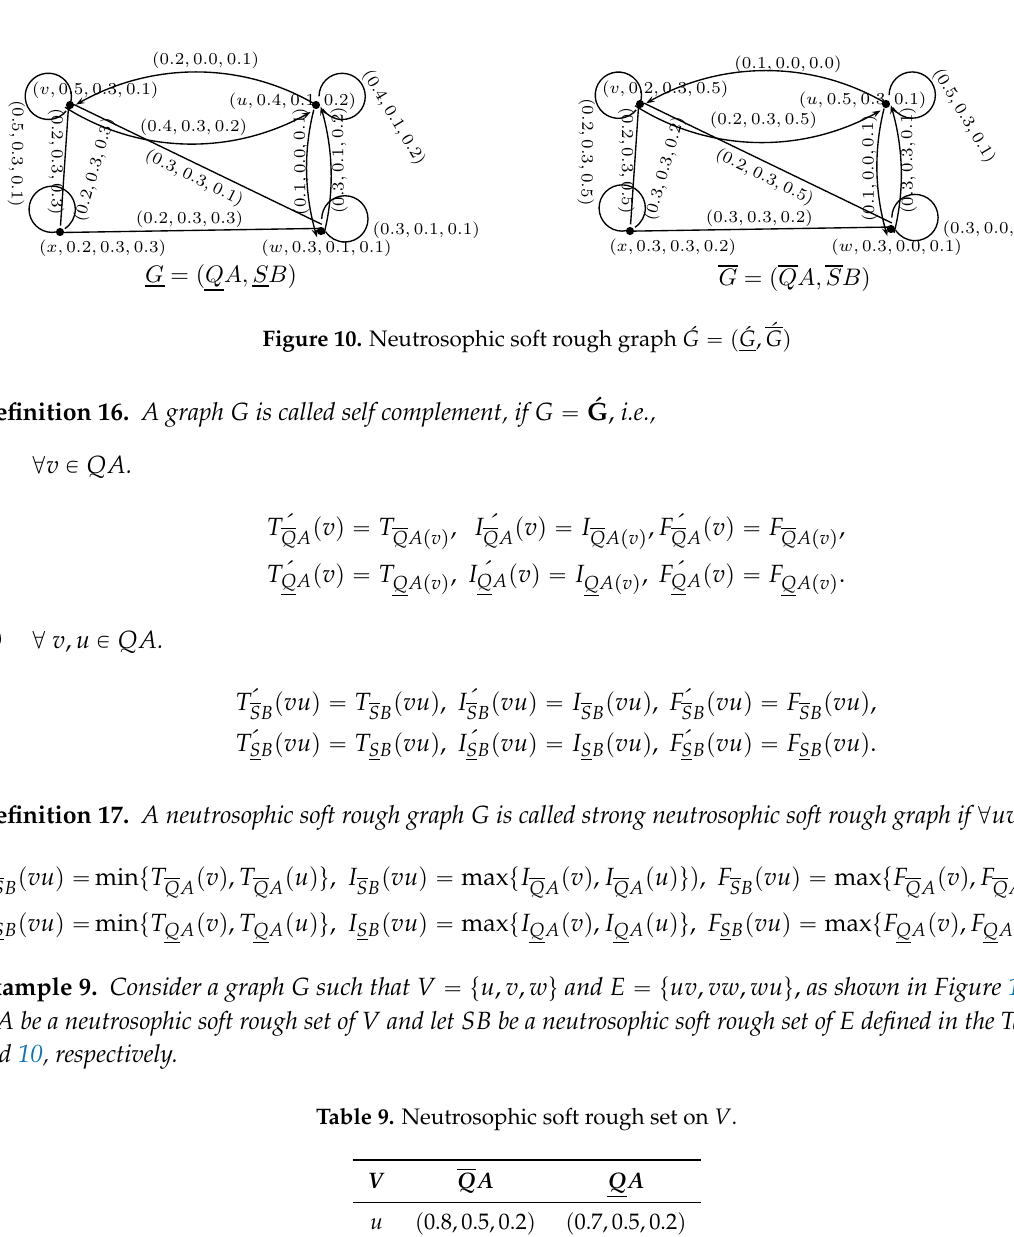
Figure 9: Neutrosophic soft rough graph G = ( G, G )